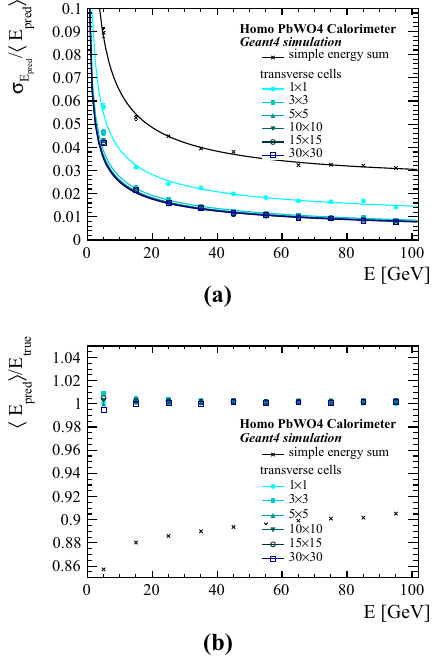
Fig. 4 Energy resolution ( a ) and linearity ( b ) for different transverse granularities with 20 longitudinal layers (stage 5). The curves show the fit to the form given in Eq. (1)